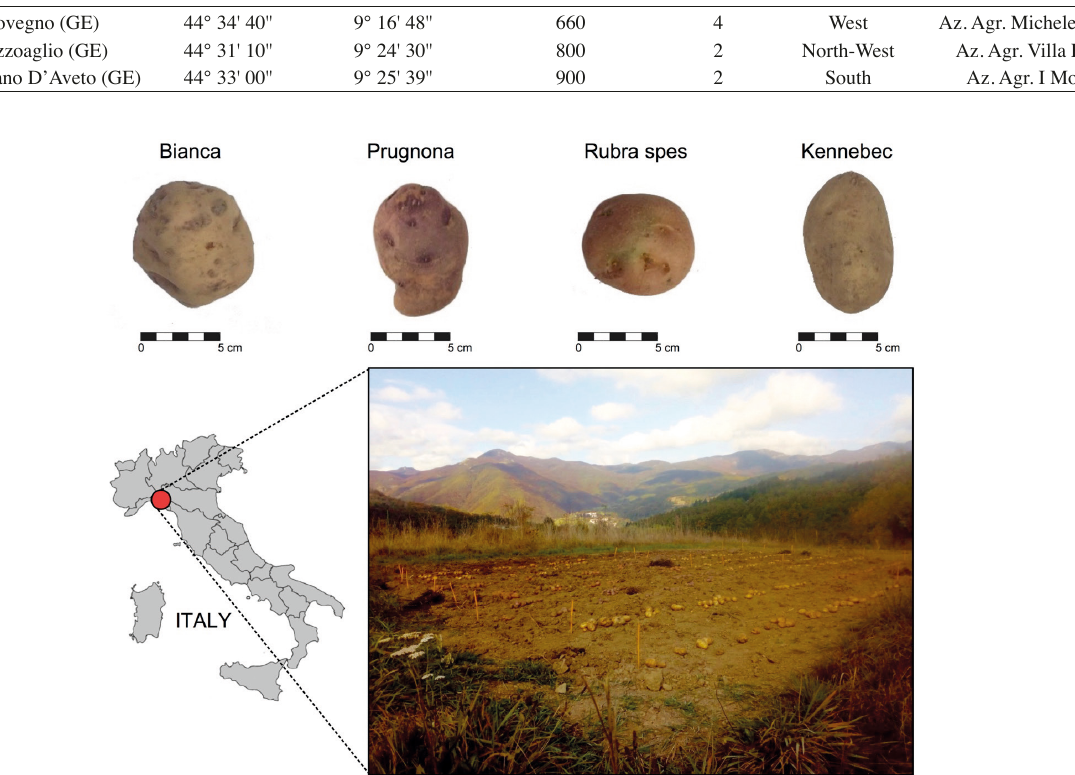
Fig. 1: Tubers of the four potato genotypes considered in this research, three are landraces of the Ligurian Apennines (Bianca, Prugnona and Rubra Spes), and one is a commercial cultivar (Kennebec). An experimental field located in Ligurian Apennines is shown.